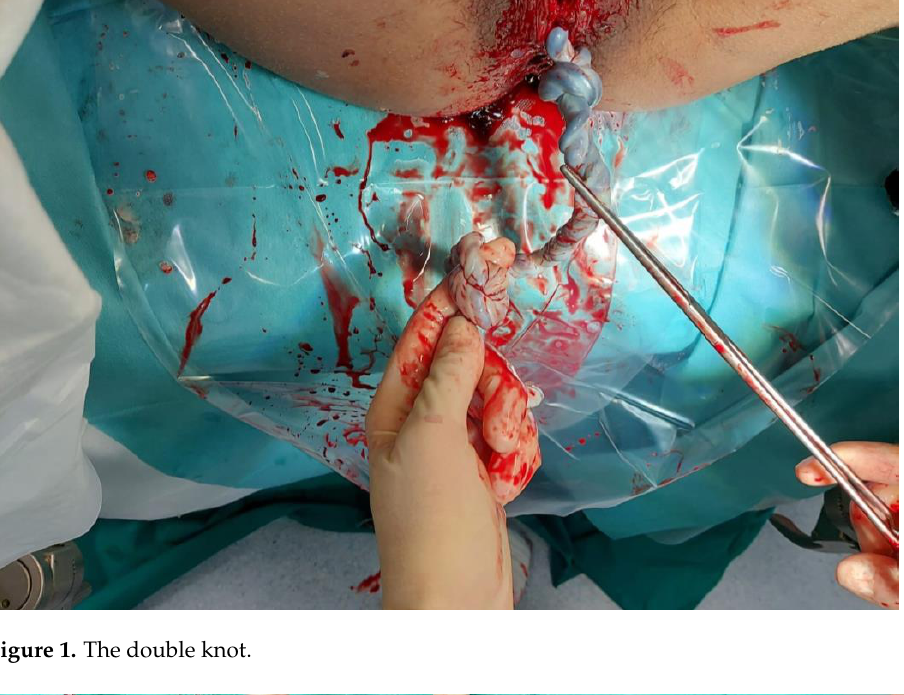
Figure 1. The double knot.